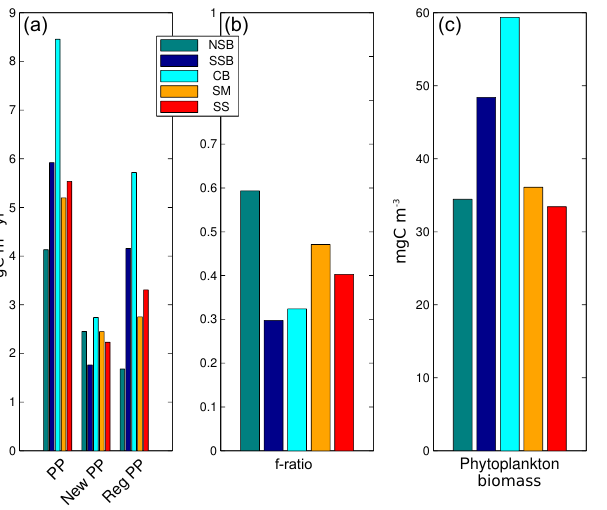
Figure 4. Annual mean of (a) primary production (PP, g Cm − 3 yr − 1 ) , new production (g Cm − 3 yr − 1 ) and regenerated production (g Cm − 3 yr − 1 ) , (b) f ratio (new and/or regenerated production) and (c) phytoplankton biomass (mg Cm − 3 ) in the coastal boxes. Each colour corresponds to a box (see legend): north- ern Saharan Bank (NSB), southern Saharan Bank (SSB), Cape Blanc area (CB), Senegalo-Mauritanian region (SM) and southern Senegal region (SS).